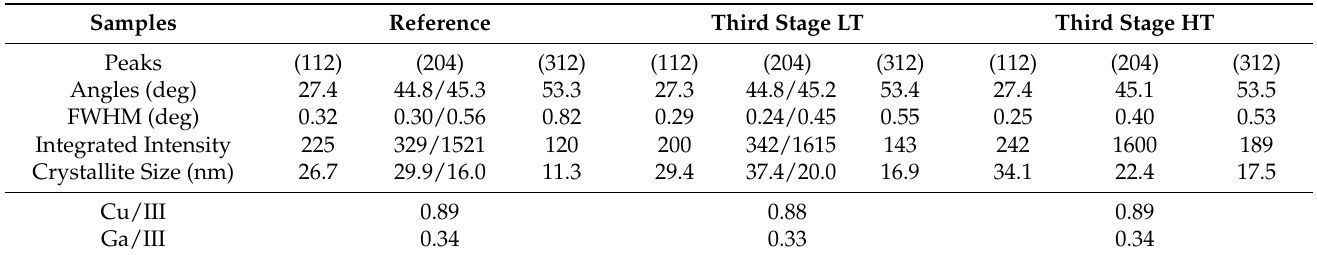
Figure 7. Secondary Ions Mass Spectroscopy (SIMS) depth profile (positive ions) of the main elements for the reference ( a ), third stage LT ( b ) and third stage HT ( c ) CuCl 2 annealed CIGS samples.